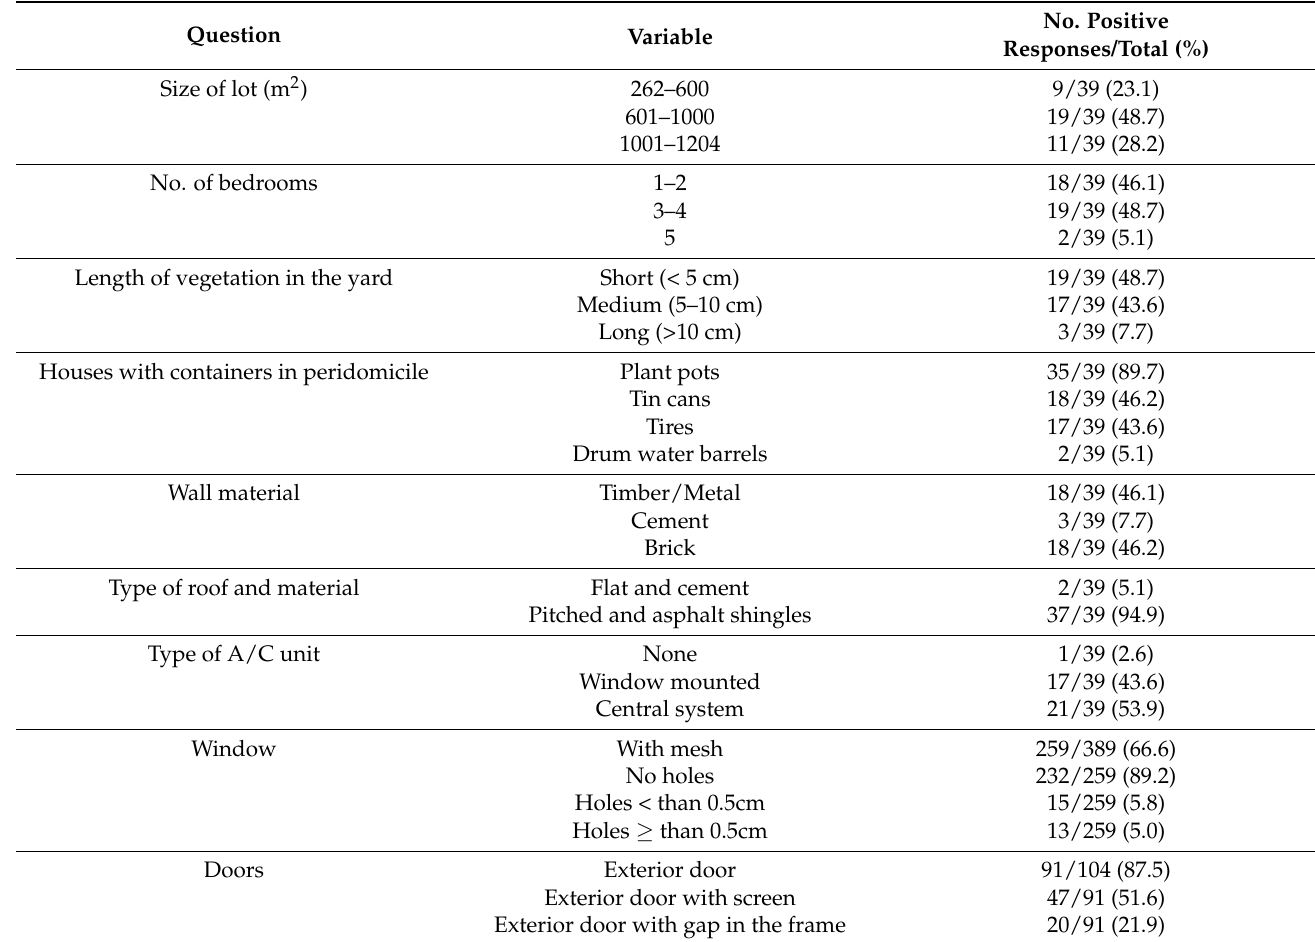
Table 5. Housing and peridomicile variables of the Lower Rio Grande